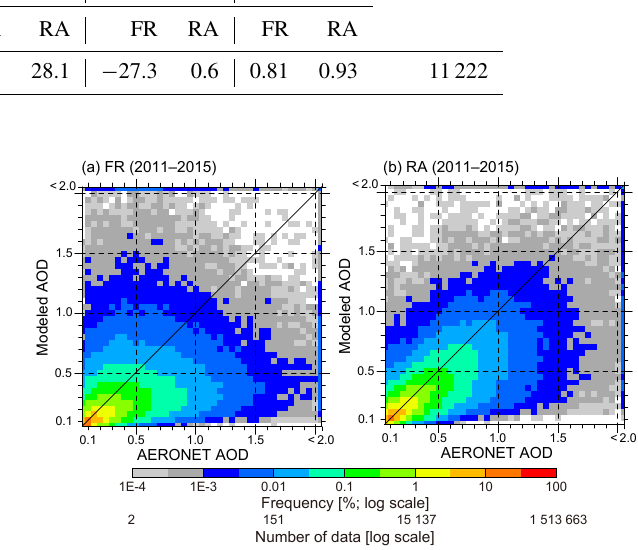
Table 4. Statistical measures of the monthly averaged AERONET AODs versus FR and RA AODs. RMSE R MFE MFB